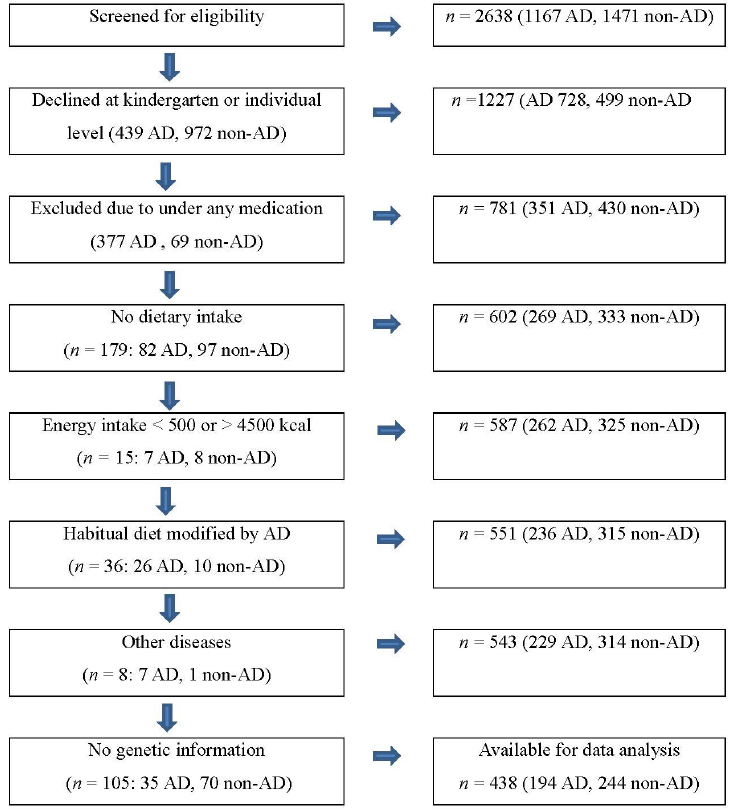
Figure 1. Sample selection process. Atopic Dermatitis (AD).